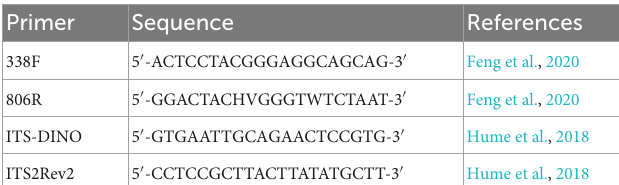
Table 1 ) by PCR using Phusion R (cid:13) High-Fidelity PCR Master Mix kit (NEB, UK). The PCR amplification of 16S rRNA was performed as follows: initial denaturation at 95 ◦ C for 3 min, followed by 30 cycles of denaturing at 98 ◦ C for 30 s, annealing at 55 ◦ C for 30 s, and extension at 72 ◦ C for 15 s, and single extension at 72 ◦ C for 5 min, and end at 4 ◦ C. The PCR products containing bands of 400–450 bp were operated using electrophoresis on 2% agarose gel for detection, and the samples were extracted from the 2% agarose gel and purified using the DNA Gel Extraction Kit (Omega, China) according to the